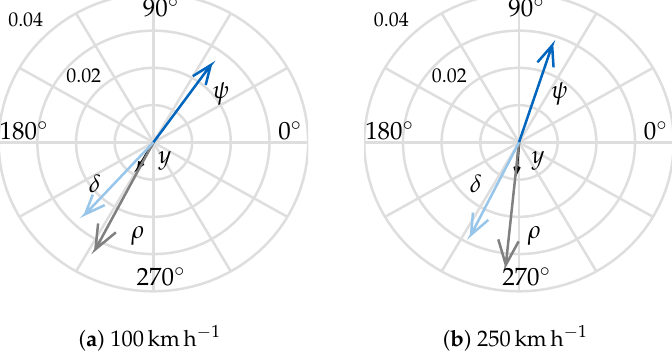
Figure 11. Compass plot of the weave eigenvector at different speeds with I fw , I rw =